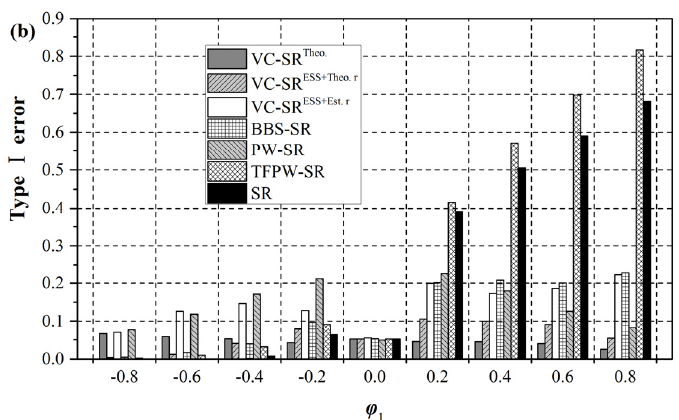
Figure 6. Comparison of Type I errors of different SR tests for AR(2) series: ( a ) n = 50; ( b ) n = 100.